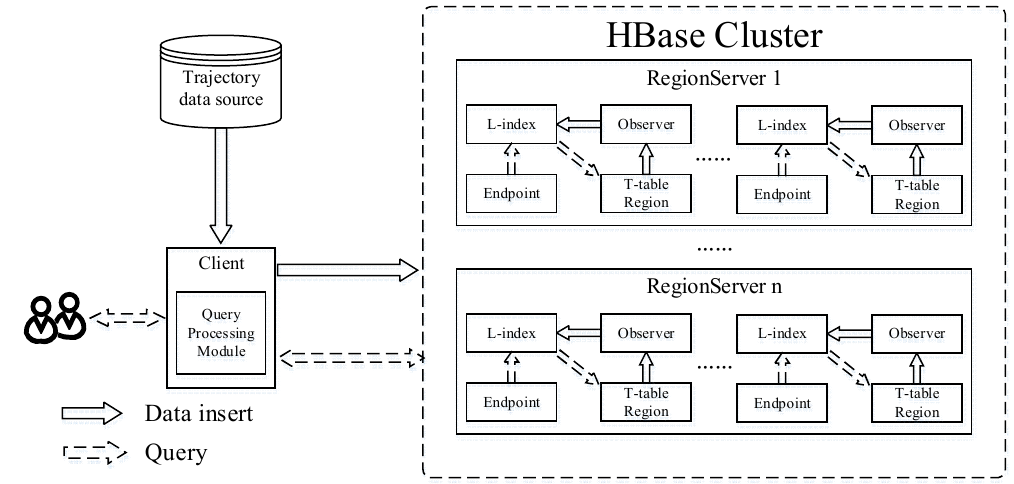
Figure 1. THBase Architecture.